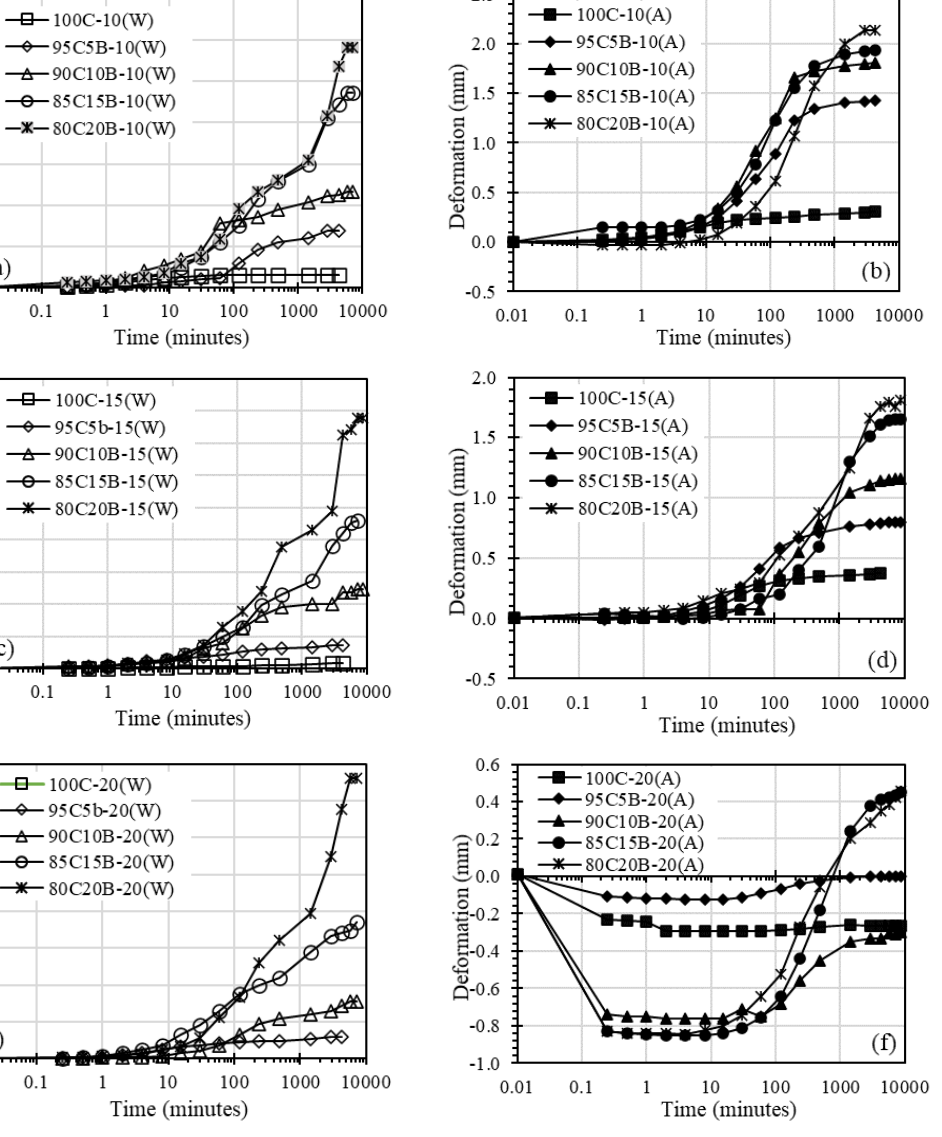
Fig. 4. Swelling development by time of claystone‒bentonite mixture samples with initial moisture content of (a)‒(b) 10%, (c)‒(d) 15%, and (e)‒(f)